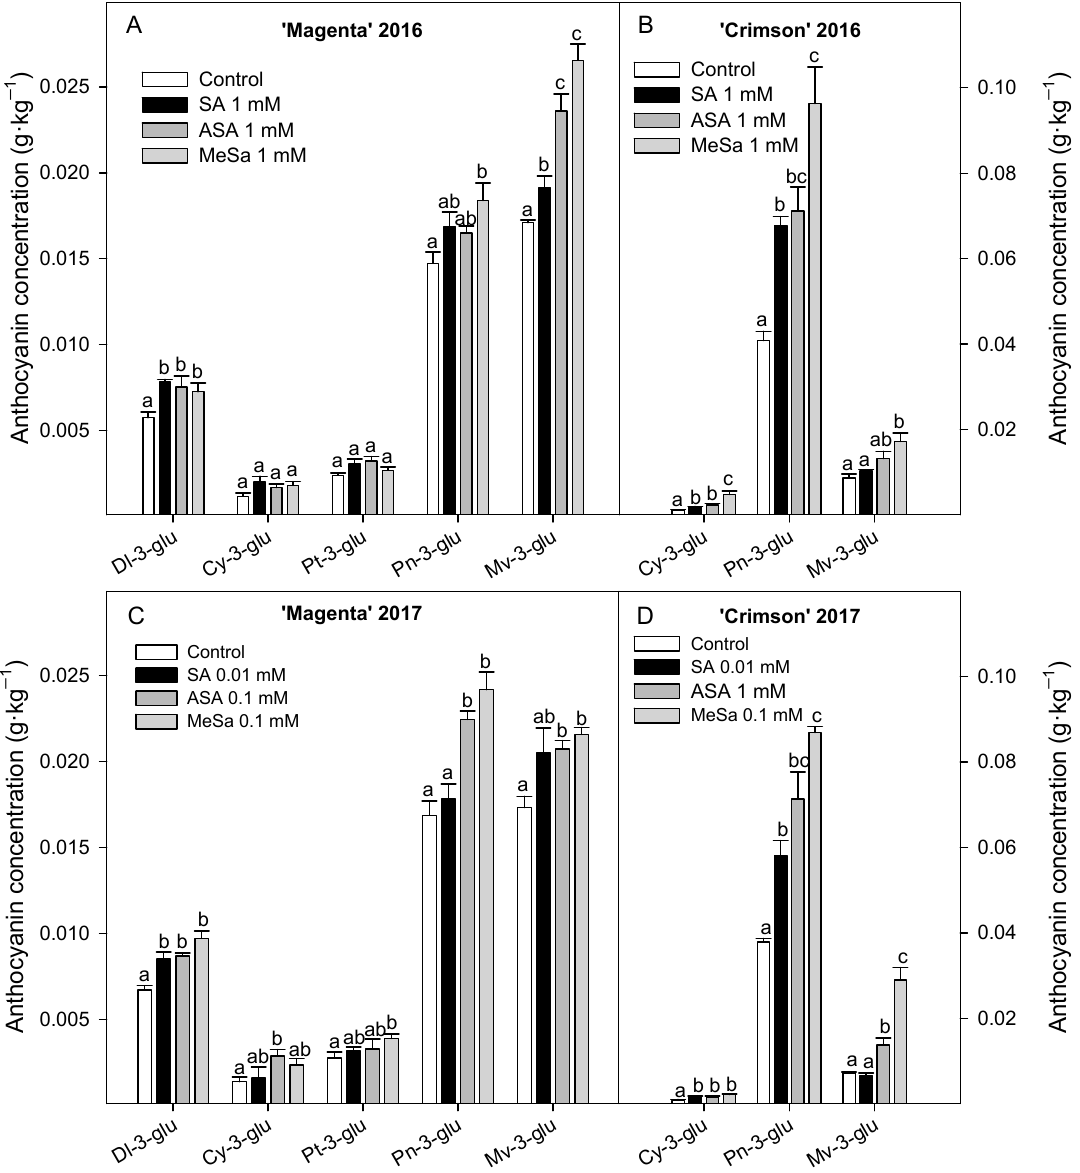
Figure 3. Individual anthocyanin concentration in ‘Magenta’ and ‘Crimson’ table grapes as affected by salicylic acid (SA), acetyl salicylic acid (SA) and methyl salicylate (MeSa) treatments at harvest in 2016 ( A and B ) and 2017 ( C and D ) experiments. Data are the mean ± SE of quantifications made in duplicate in three replicates. Different letters show significant differences ( p < 0.05) among treatments for each individual anthocyanin.